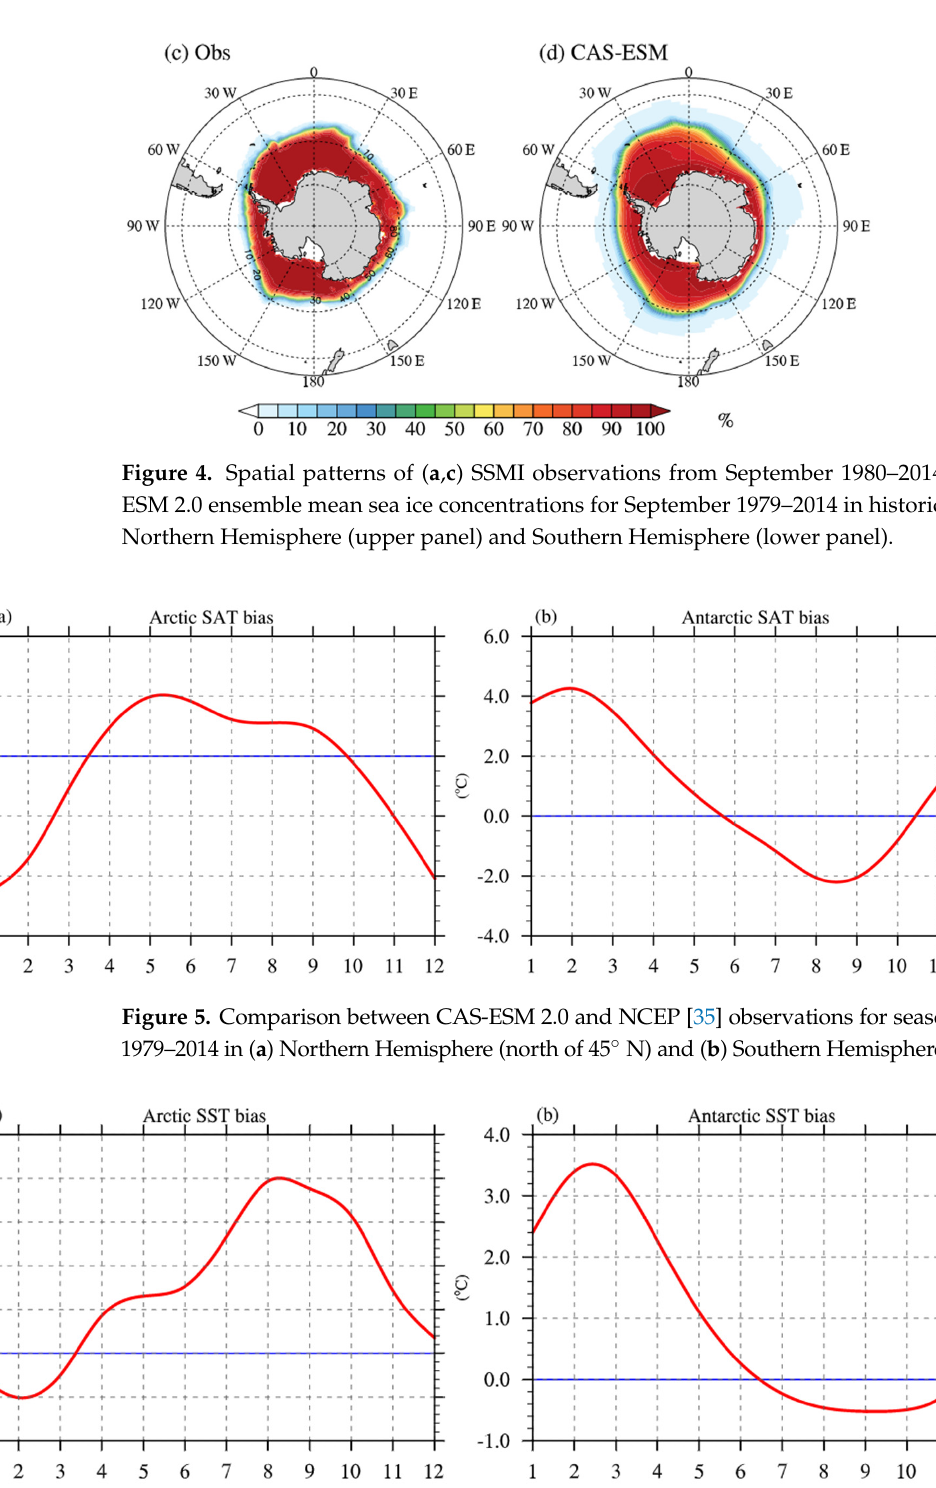
Figure 6. Comparison between CAS-ESM 2.0 and WOA 13 [36] observations for seasonal SST cycle in 1979–2014 in ( a ) Northern Hemisphere and ( b ) Southern Hemisphere.